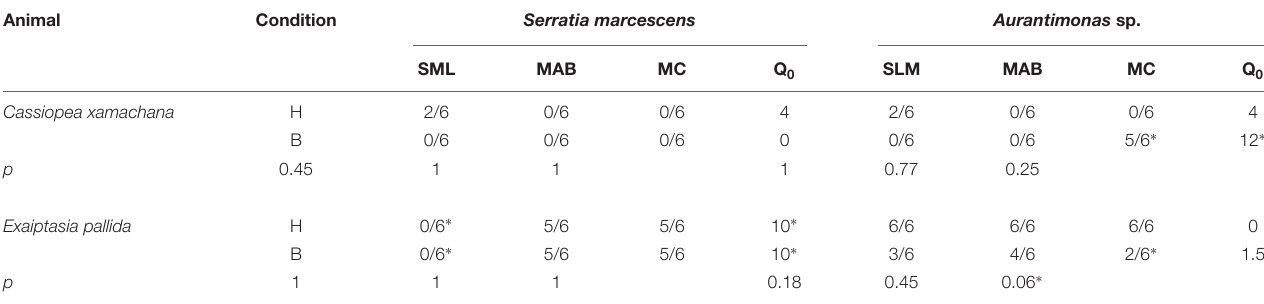
TABLE 3 | Frequency for the presence of inhibition growth zone of treated mucus collected from healthy or bleached Exaiptasia pallida (anemone) and Cassiopea xamachana (medusa). Animal Condition